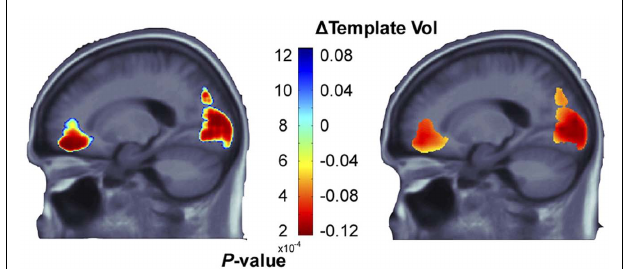
FIGURE 1 | p -values (corrected using the false discovery rate method; left panel) and corresponding regression coefficients (right) show the statistical associations between a candidate single nucleotide polymorphism in the FTO gene (which is associated with higher risk of obesity) and tensor-based morphometry maps derived from anatomical MRI scans of the brain. Significant associations with regional brain volumes are detected in the occipital and frontal lobes. Clearly, if other regions had been specified in advance as the target of study, association effects may have been missed. Adapted from Ho et al. (2010).